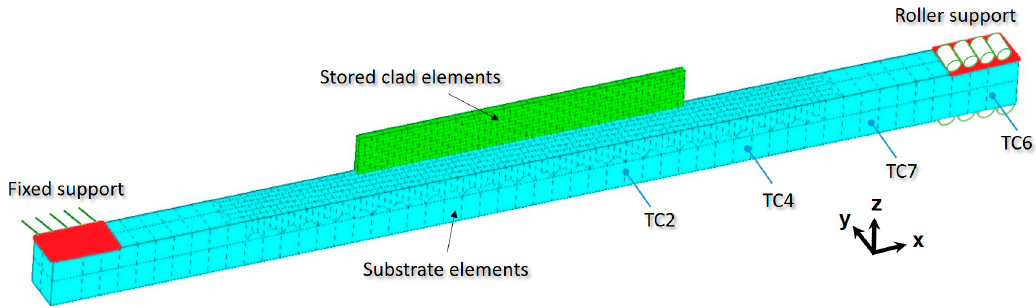
Figure 4. Initial symmetric mesh with the stored clad element (green) for future element activation, the mechanical boundary conditions in red (on the left, all the displacements x,y,z are fixed, while on the right, only z displacements are prevented).